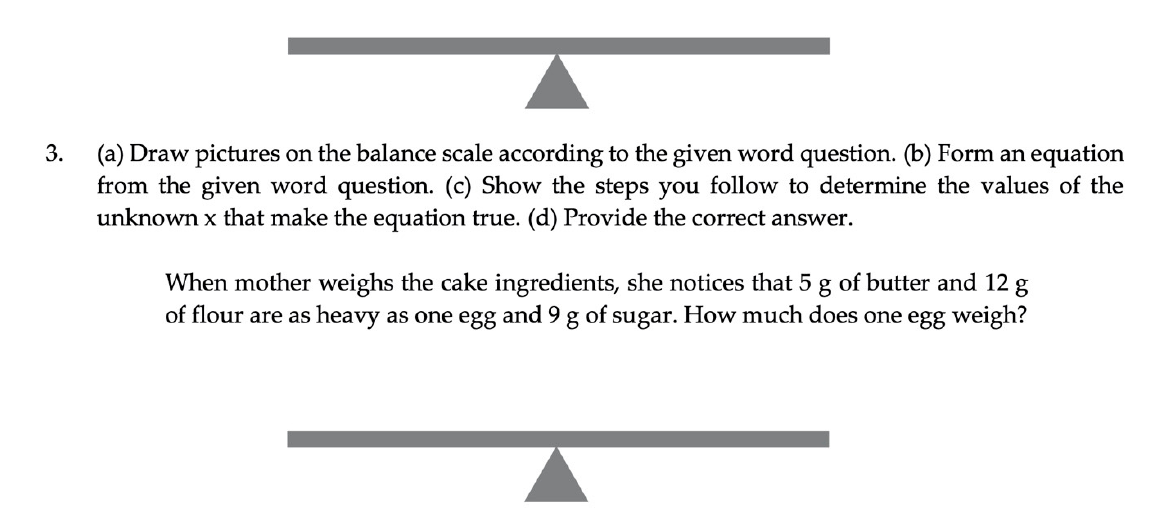
Figure A1. The three types of the paper-based test items.